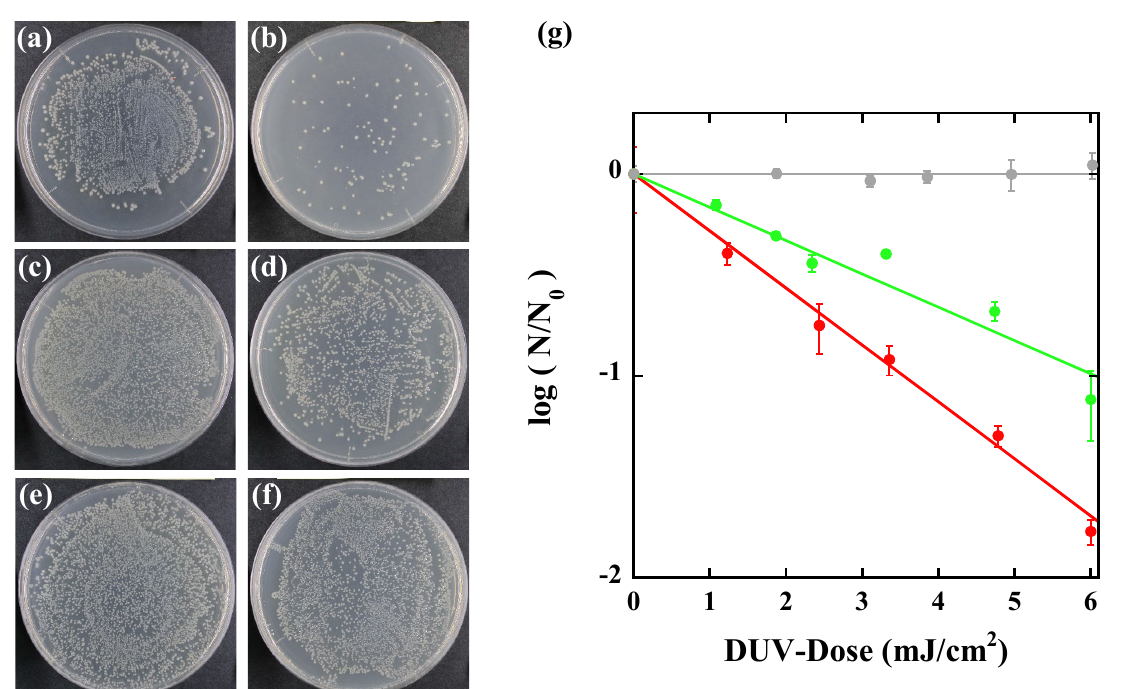
Figure 4. Efficacy of inactivation using the WW purification system for E. coli O1. ( a , c , e ) are the results of control plate (0 mJ/cm 2 DUV dose), ( b ) is the plate inactivated by a 6.0 mJ/cm 2 dose of 265 nm irradiation, ( d ) is the plate inactivated by a 6.0 mJ/cm 2 dose of 280 nm irradiation, and ( f ) is the plate inactivated by a 6.0 mJ/cm 2 dose of 308 nm irradiation. ( g ) Reduction rate of inactivation as a function of the magnitude of the dose for each wavelength. The red circles are obtained by 265 nm irradiation, the green circles are obtained by 280 nm irradiation, and the gray circles are obtained by 308 nm irradiation. The reduction curves of inactivation for each irradiation wavelength are fitted by κ 265 = 0.65, κ 280 = 0.38, and κ 308 = 0. These values agree well with the values described in Table 1, which are obtained by the wavelength-dependent inactivation rate constant experiments.